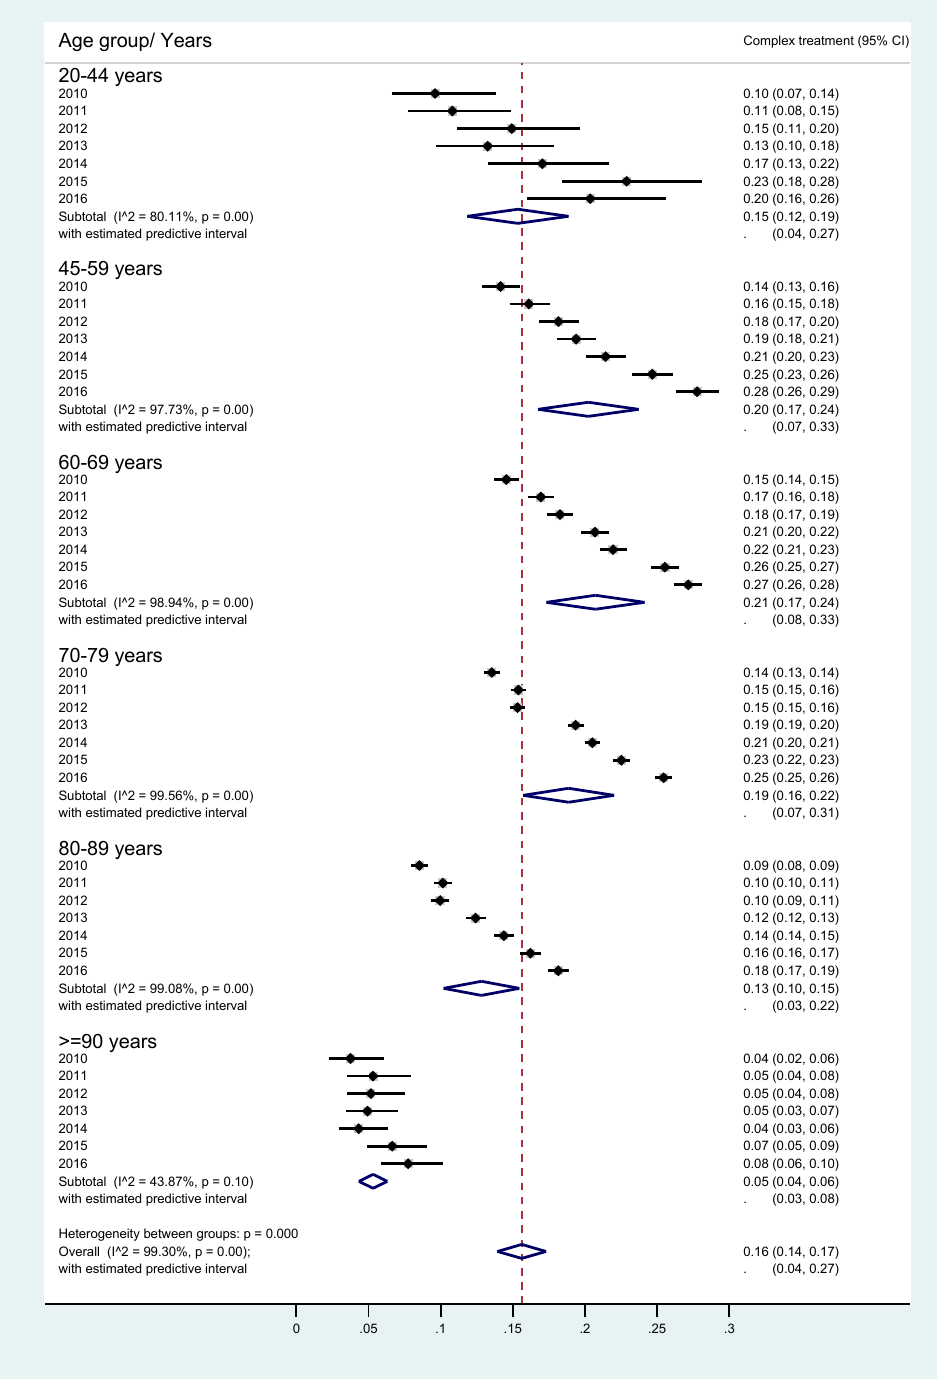
8 Figure 3. PD-MCT procedures of the year 2016. ( A ) Relative shares of all PD-MCT procedures subdivided for PD and other basal ganglia disorders (ICD G20–G23). ICD codes are described in detail in Table 1. (B – D) PD-MCT treatment rate in patients with primary Parkinson´s syndrome (ICD G20.– ) (B) , with secondary Parkinson´s syndrome (ICD G21.–) (C) or with other degenerative disease of the basal ganglia (ICD G23.–) (D) .